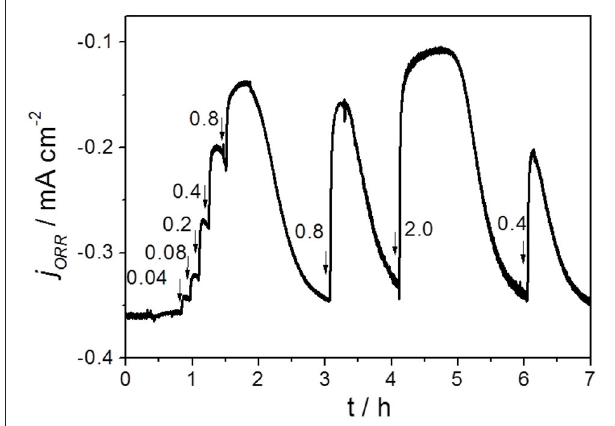
FIGURE 3 | Chronoamperogram showing the acetate crossover effect on the air-cathode performance in another duplicate MFC recorded in air at a constant potential of − 0.3V vs. Ag/AgCl (sat. KCl). Arrows and numbers indicate injection of acetate solutions with different mM concentrations.